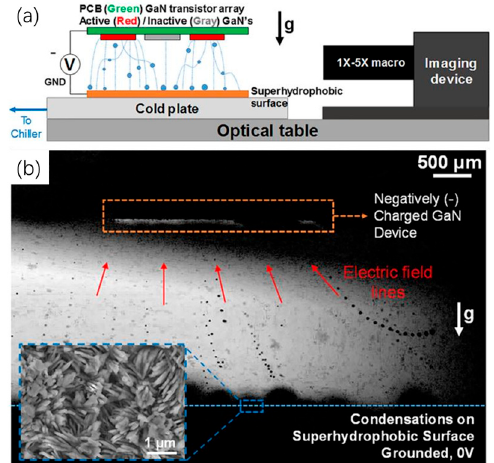
Figure 7. ( a ) Schematic of the experimental setup for jumping droplet cooling of GaN transistors. ( b ) Composite high-speed image of jumping droplet condensation. Reproduced with permission from [68]; published by AIP publishing, 2017.